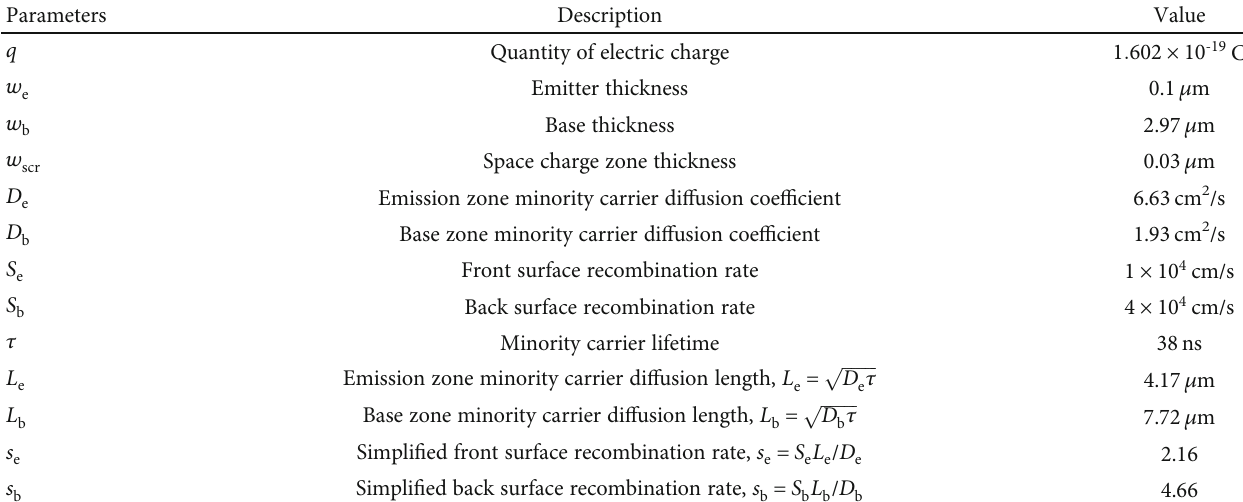
Table 3: Parameters in the current density equation (Equation (2)) are derived from the minority carrier di ff usion equation. Parameters